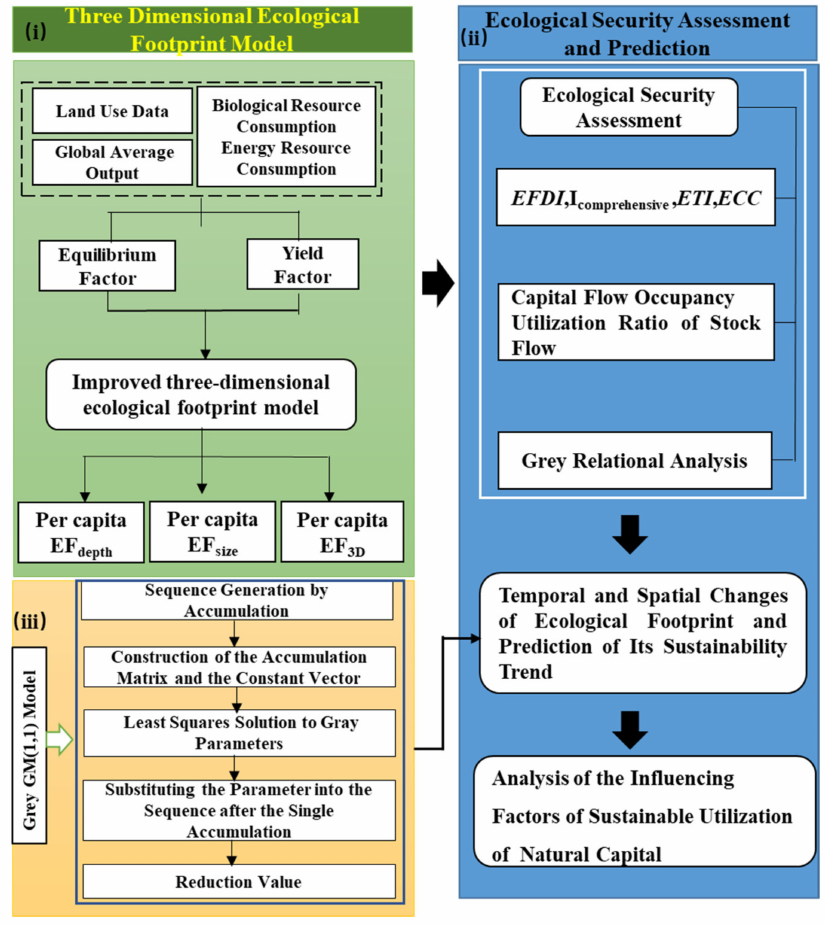
Figure 2. Research